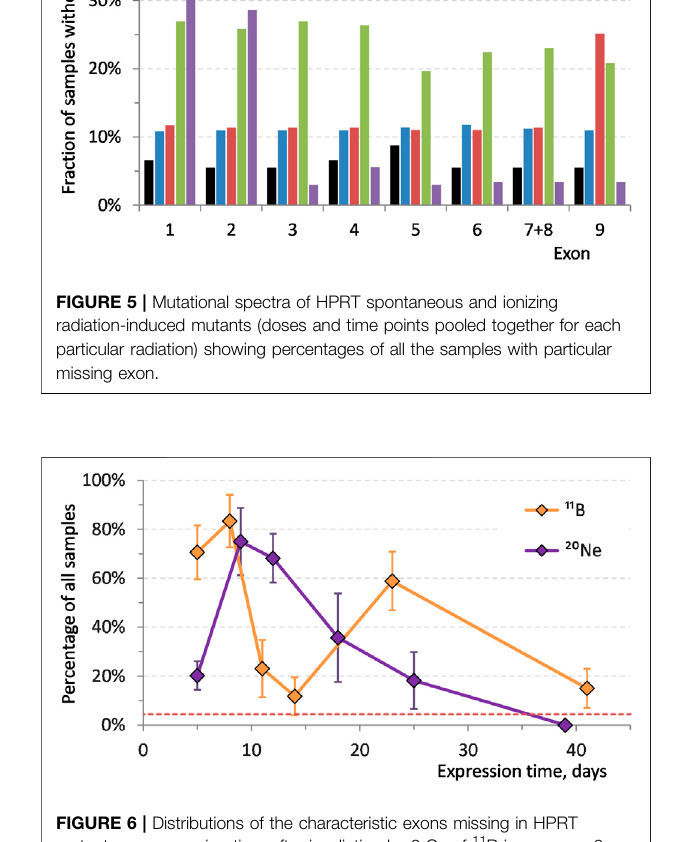
Frontiers in Physics |